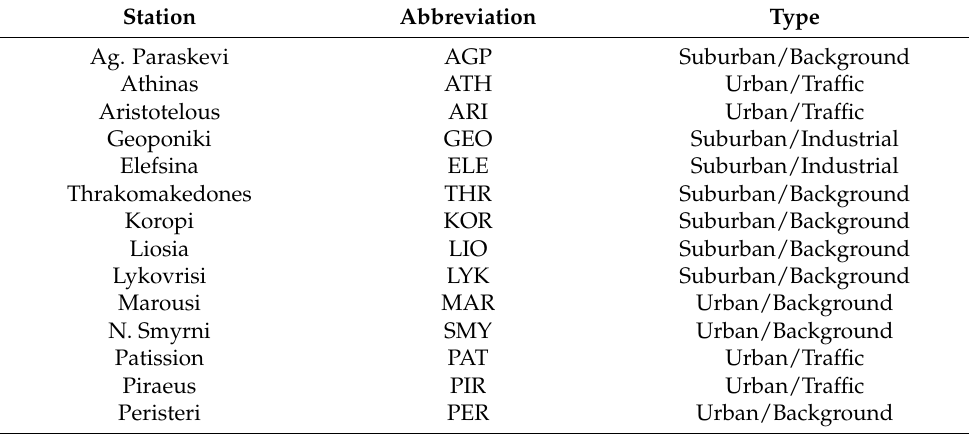
Table 1. Air-quality-monitoring stations and their corresponding abbreviation and